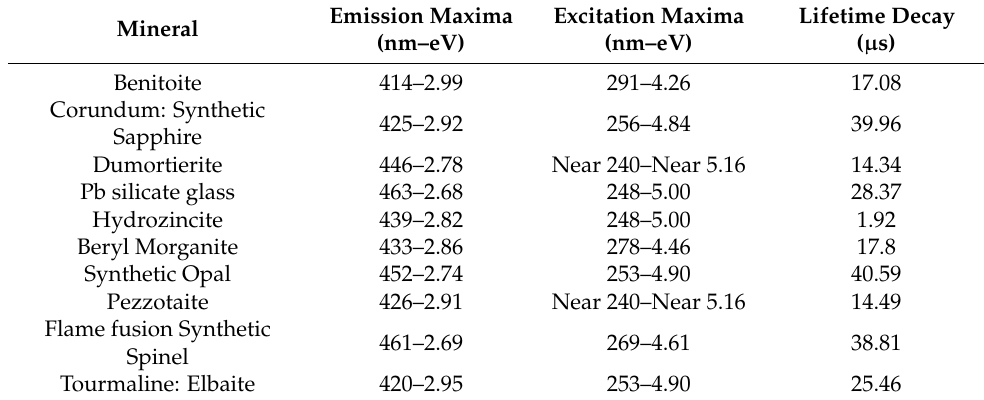
Table 7. Emission/excitation maxima of the ten samples showing BSL and associated lifetime